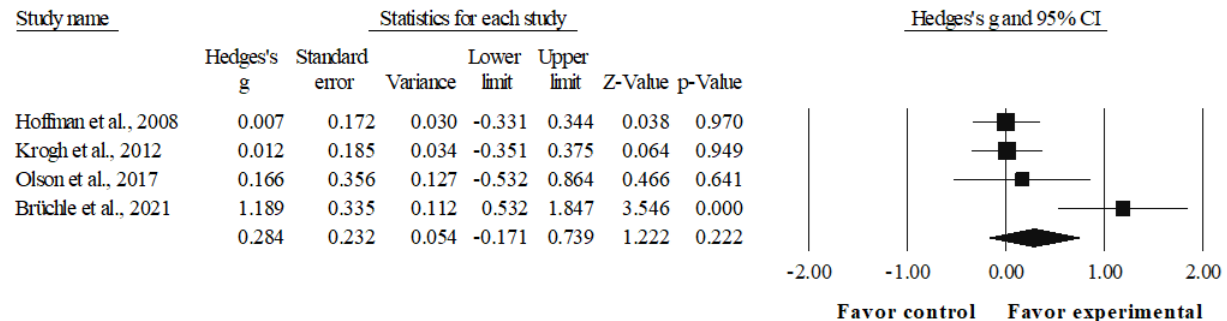
Figure 3. Forest plot for inhibition outcome. Values shown are effect sizes (Hedges’s g) with 95% confidence intervals. The size of the plotted squares reflects the statistical weight of the study. Black squares: individual studies. Black rhomboid: summary result.